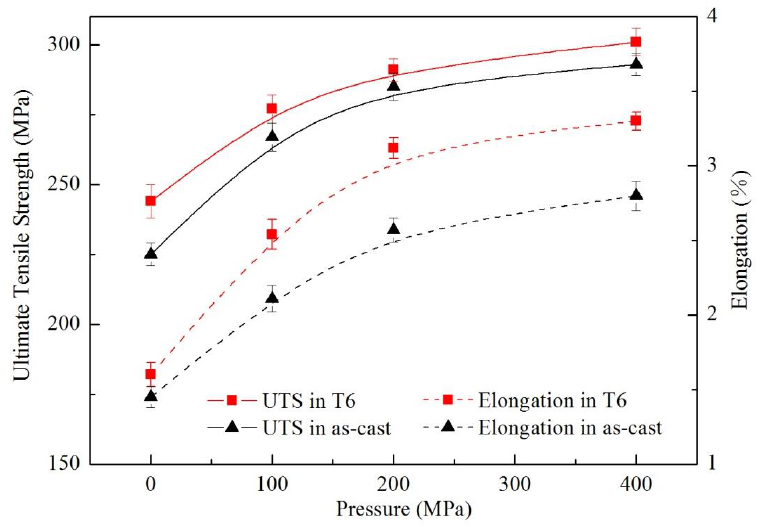
Figure 15. Ultimate tensile strength (UTS) and elongation of HPRSC A3 alloy with UV-ES compound field treatment.